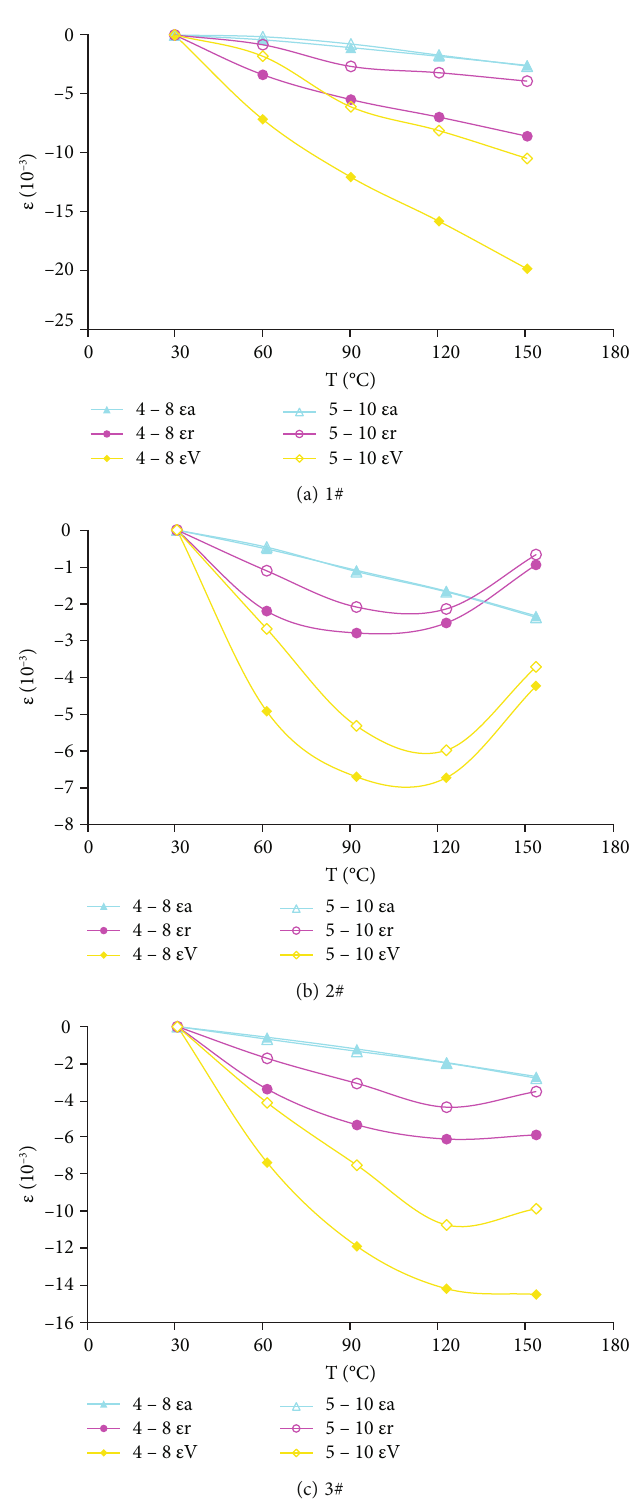
Figure 2: Relationship between thermal expansion deformation and temperature under di ff erent stress